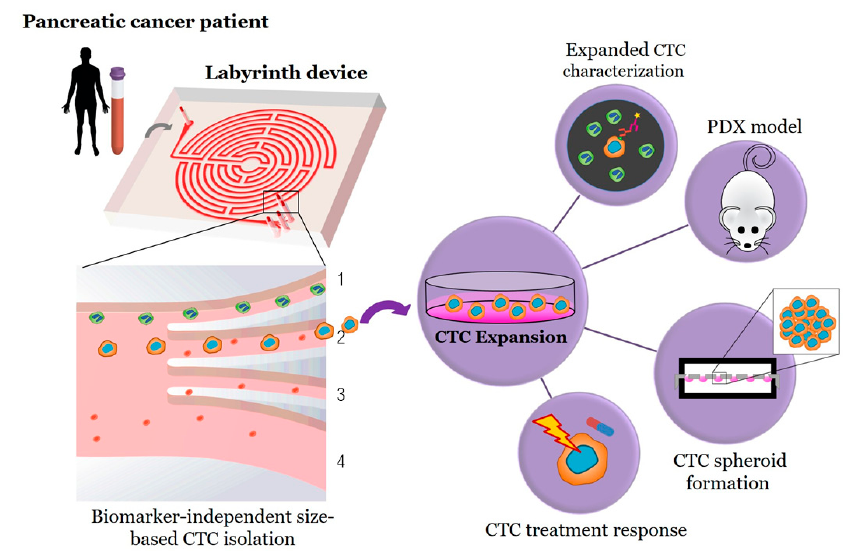
Figure 1. Workflow for biomarker independent isolation, expansion, and analysis of circulating tumor cells (CTCs). Through inertial focusing during Labyrinth processing, the CTCs (red cells) and WBCs (green cells) focus to unique streamlines. The WBCs focus to Outlet 1 and are depleted from the sample, while the CTCs are collected through Outlet 2 for further testing.